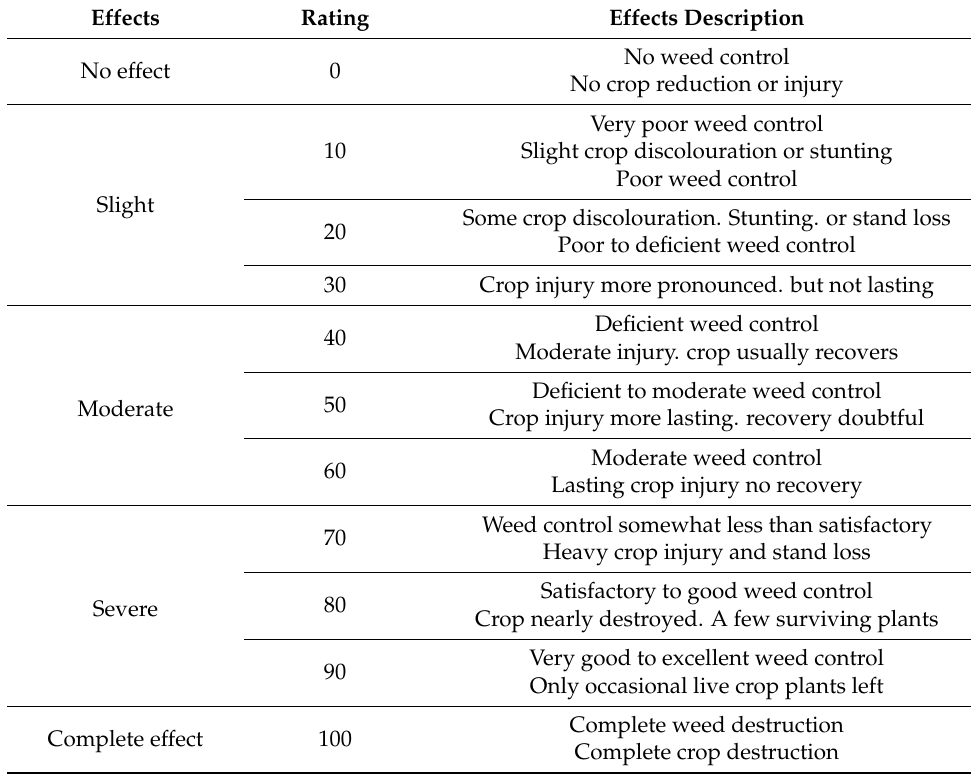
Table 1. Rating system used to assess weed control